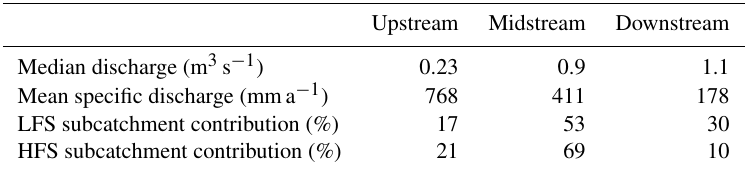
Table 2. Descriptive statistics on discharge at the three observation points; LFS – low-flow season (June–November), HFS – high-flow season (December–May).